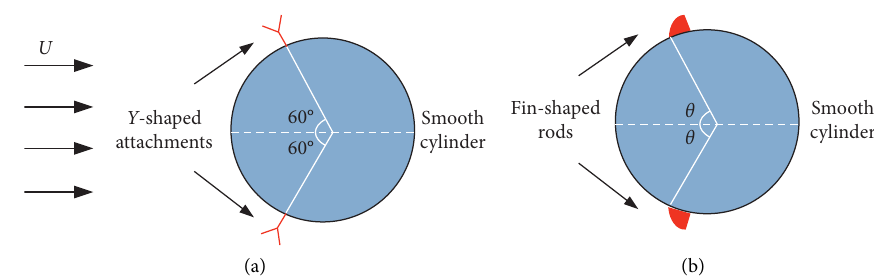
Figure 7: (a) Y -shaped attachments [64]. (b) Fin-shaped strips [65]. Table 3: Brief summary of reported studies on piezoelectric harvester using localized roughness.